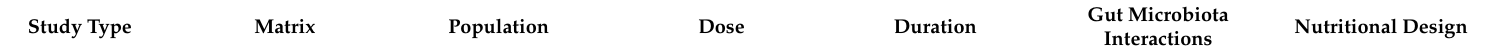
Table 6. Selected studies on the study of grape phenolic compounds’ health effects in gut